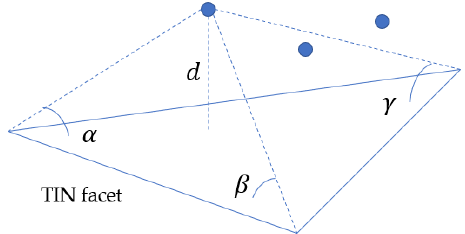
Figure 14. Calculated values for a data point during TIN densification.